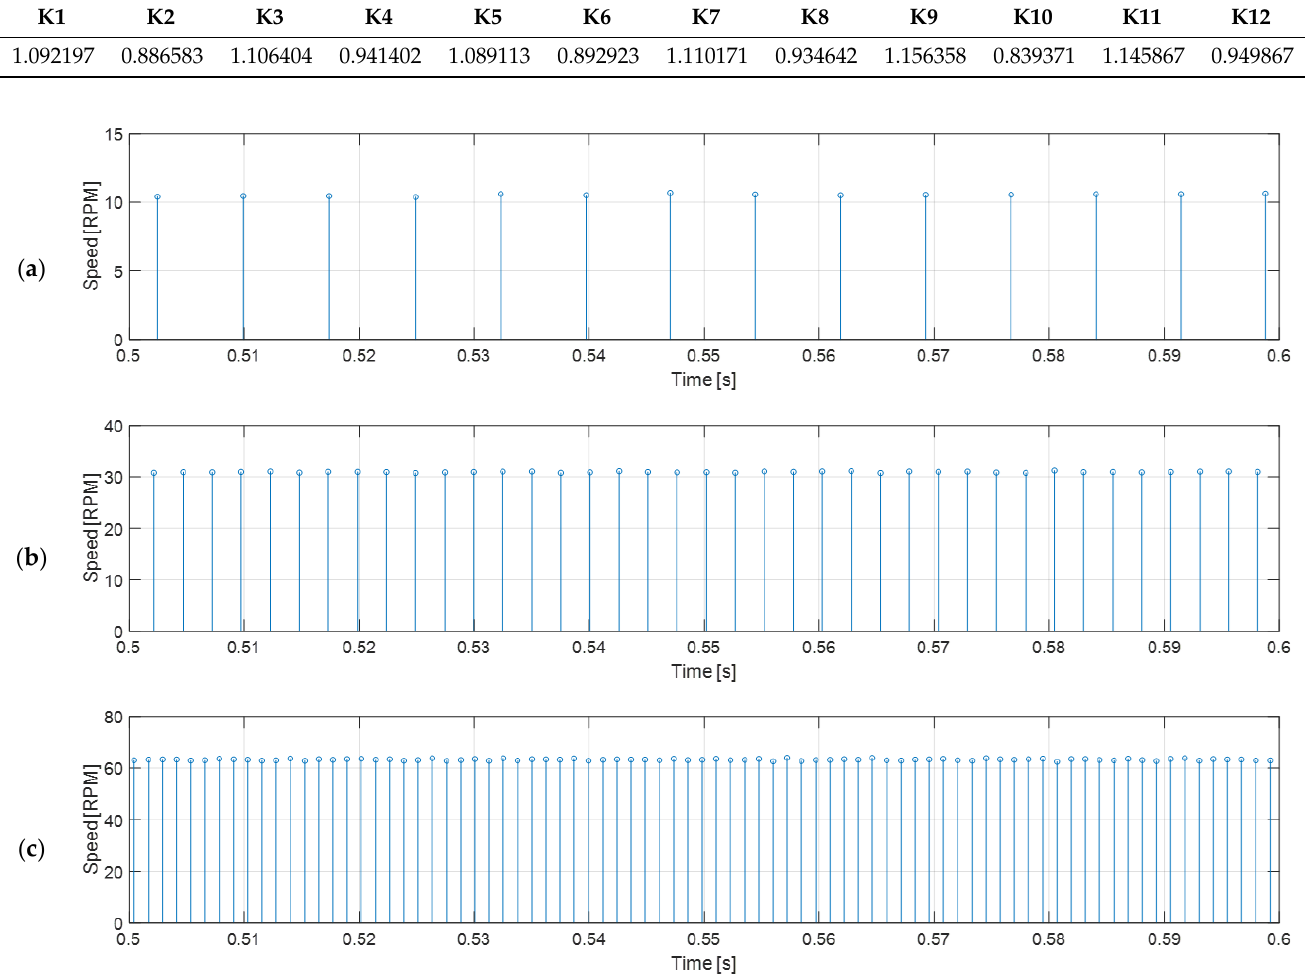
Figure 8. Corrected open-loop wheel speed measurement deduced from the raw time-elapsed edge measurements gathered from the magnetic encoder of the BDCM for the different PWM duty cycles applied and the correction coefficients displayed in Table 1: ( a ) 20% PWM case; ( b ) 50% PWM case; ( c ) 100% PWM case.